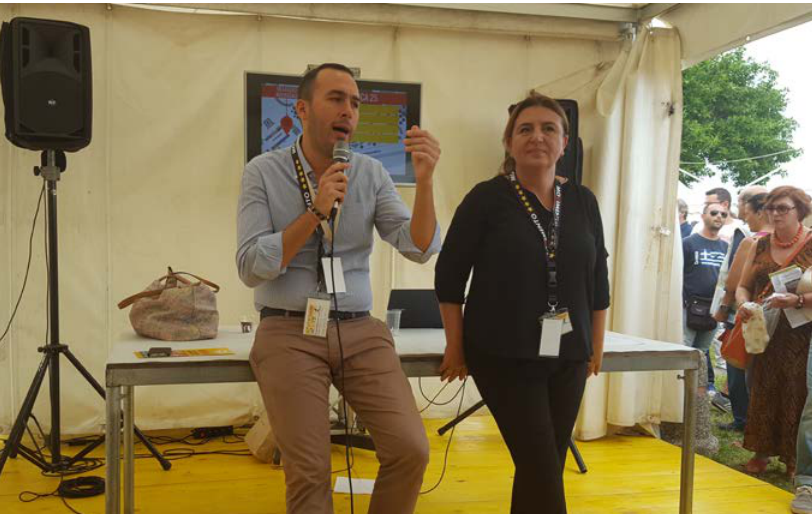
Figure 3: Manlio Di Stefano and Nunzia Catalfo present Lex Parliament , Palermo, September 25, 2016 . (photo: Marco